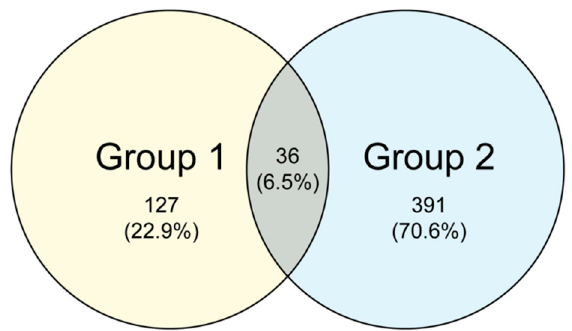
Figure 2. Venn diagram demonstrating the shared and unique operational taxonomic units (OTUs) among the microbiomes of the non-fertilized (Group 1) and fertilized eggs (Group 2) of N. lugens .